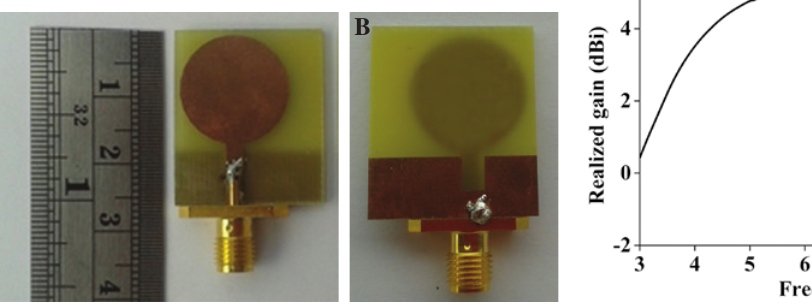
Figure 11: Measured realized gain of the proposed